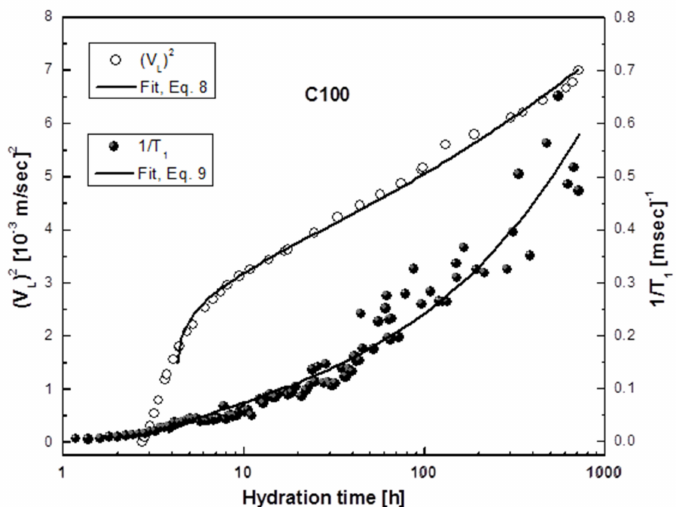
Figure 11. Fit of Equations (8) and (9) to the NMR data (black circles) and ultrasonic data (white circles) for the reference specimen C100 to obtain the percolation parameters p c as described in the